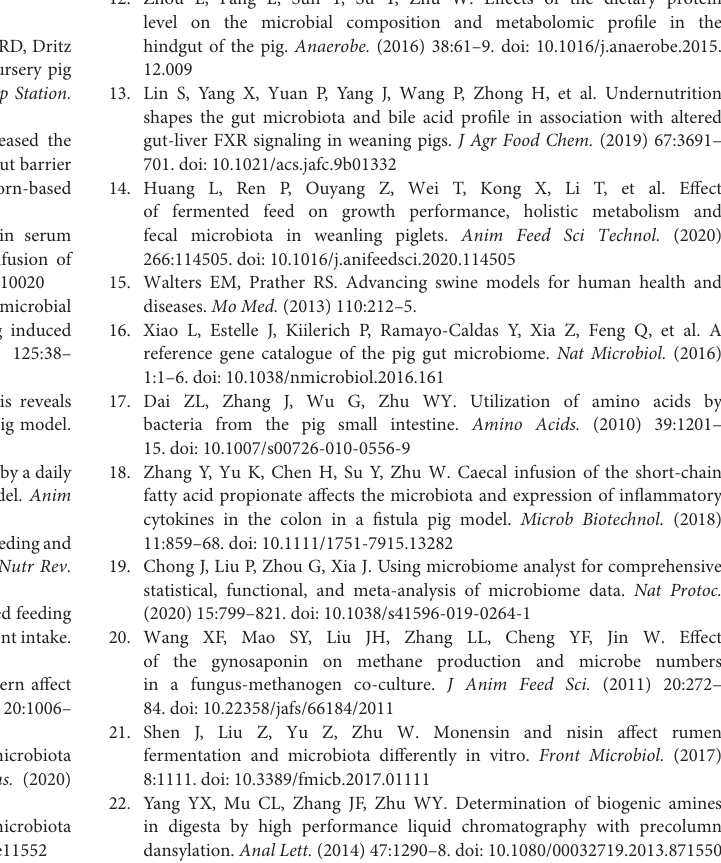
Supplementary Figure 1 | Rarefaction curve comparing the number of OTUs found in the 16S rDNA gene libraries from microbiota in the colon. Supplementary Figure 2 | Principal coordinate analysis (PcoA) of the colonic bacterial community of the growing pigs ( n = 6). FA, free access group; TRF, time-restricted feeding